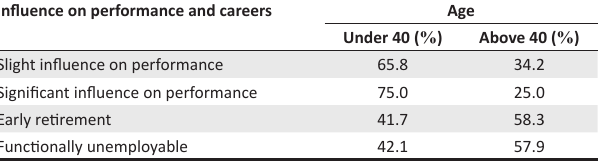
TABLE 1a: The cross tabulation of ages and their influence on performance and careers. Influence on performance and careers